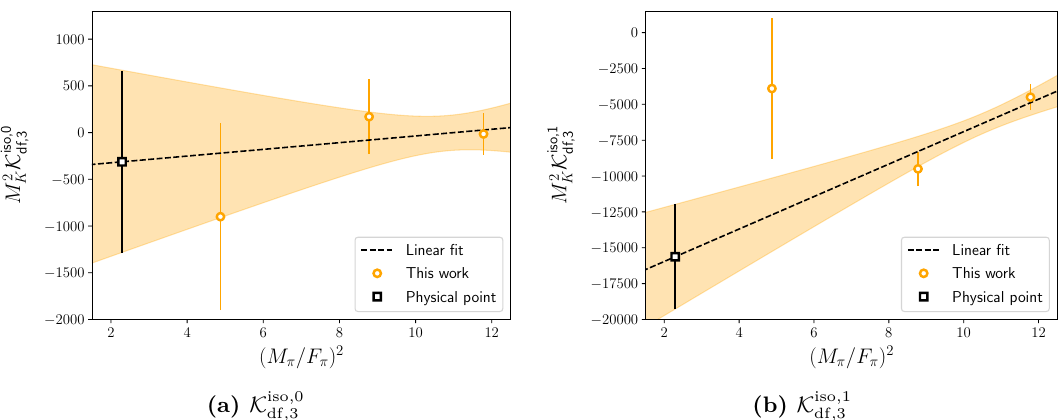
Figure 13. Results for the isotropic parameters in K df , 3 for kaon scattering. Notation as in figure 5.